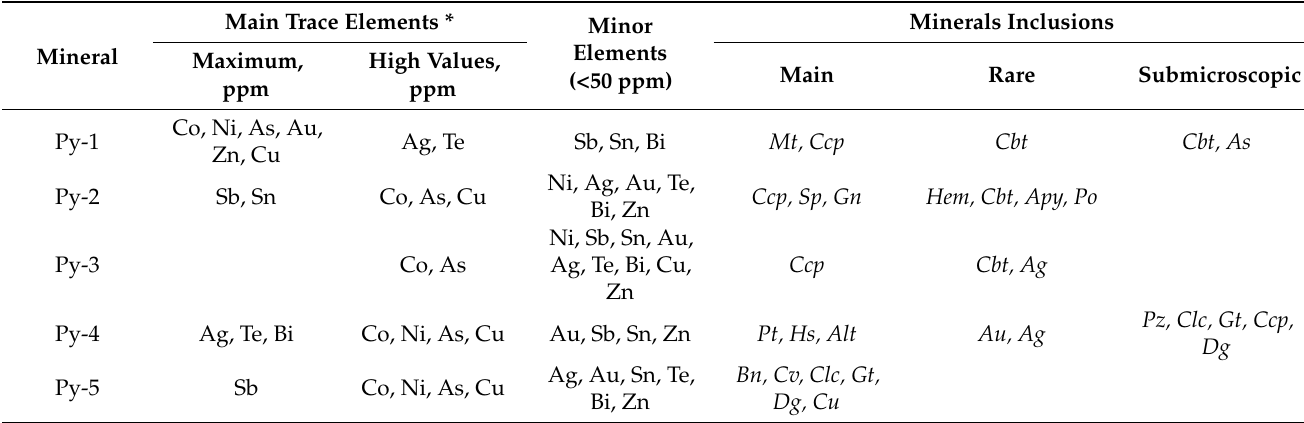
Table 15. Occurrence forms of main and trace elements and their mineral inclusions in pyrite of different assemblages at the Novogodnee-Monto deposit.